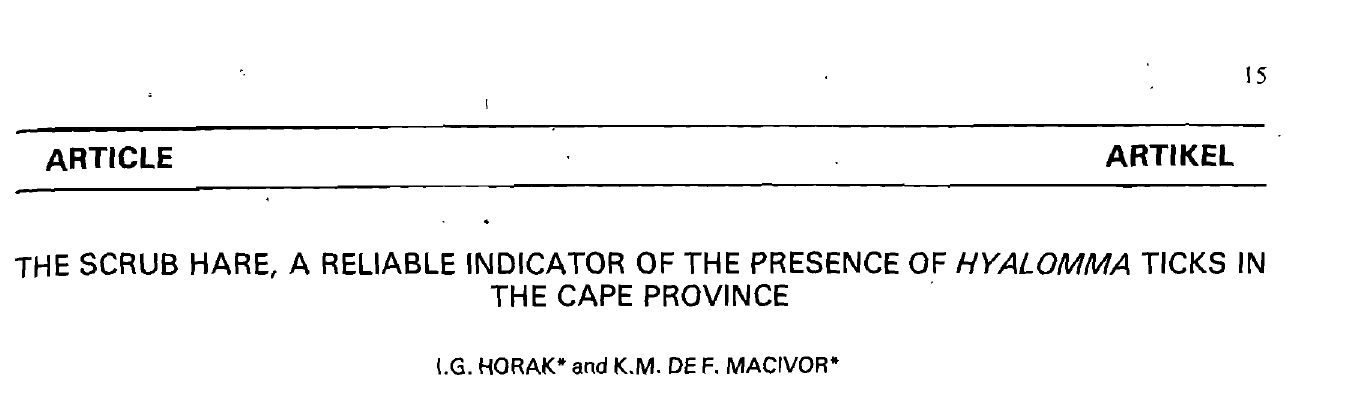
Fig. 2: The distribution of I-!yalomma marginatum turanicum in the Republic of South Africa 11